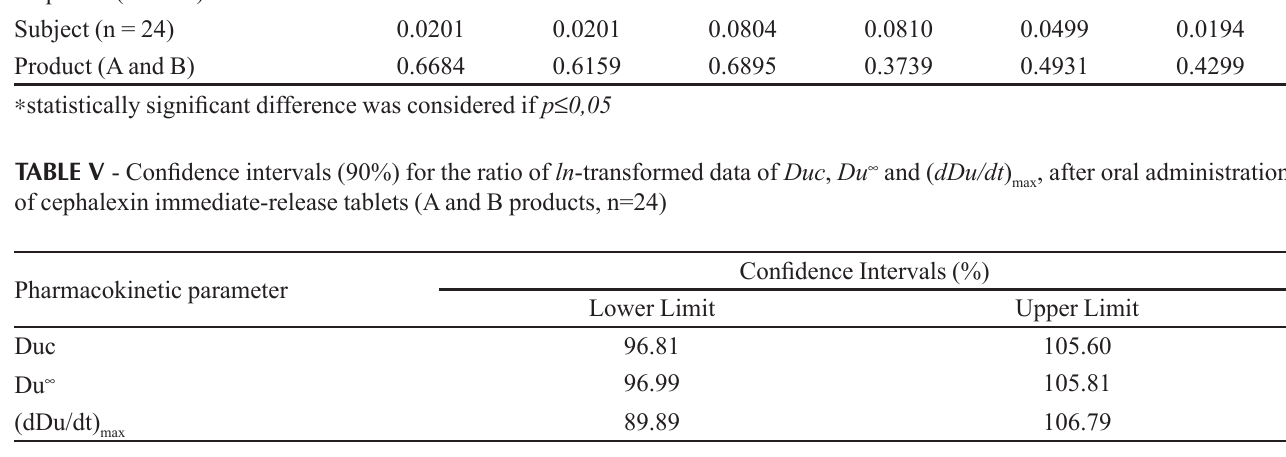
); cephalexin excretion max